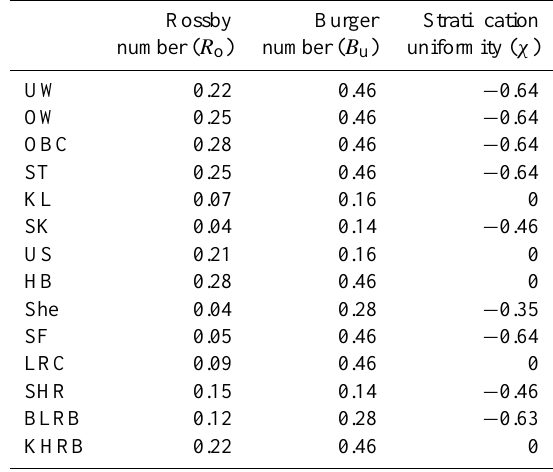
Table 3. Non-dimensional parameters for all model simulations.